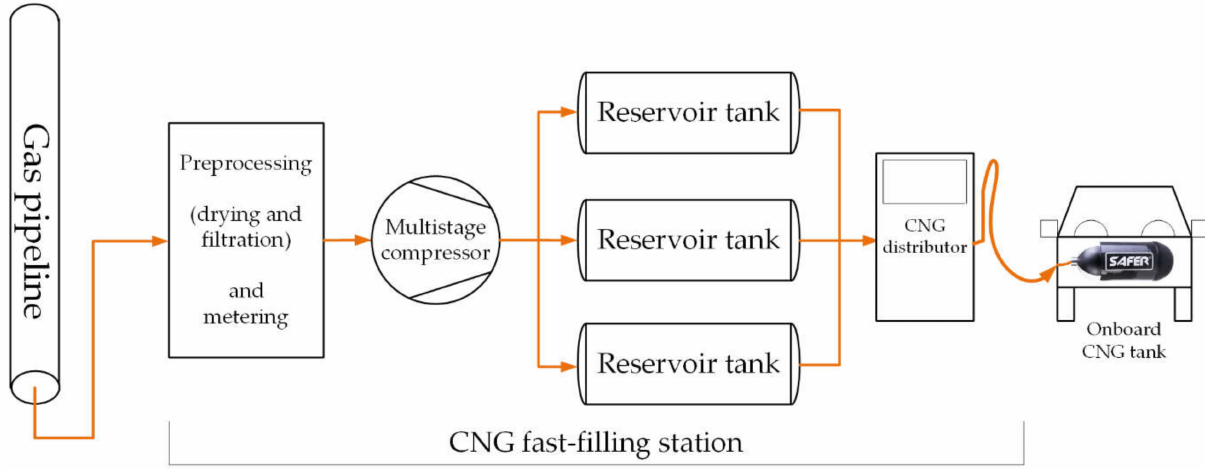
Figure 1. Scheme of the fast-filling process (cascade storage) of the composite tank (type